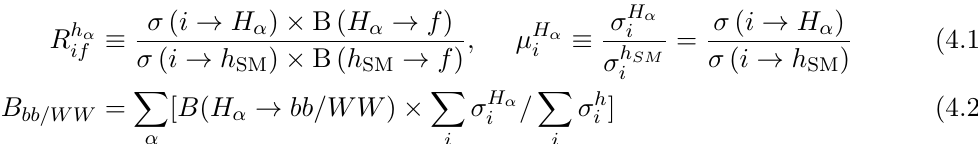
and N themselves are 13 14